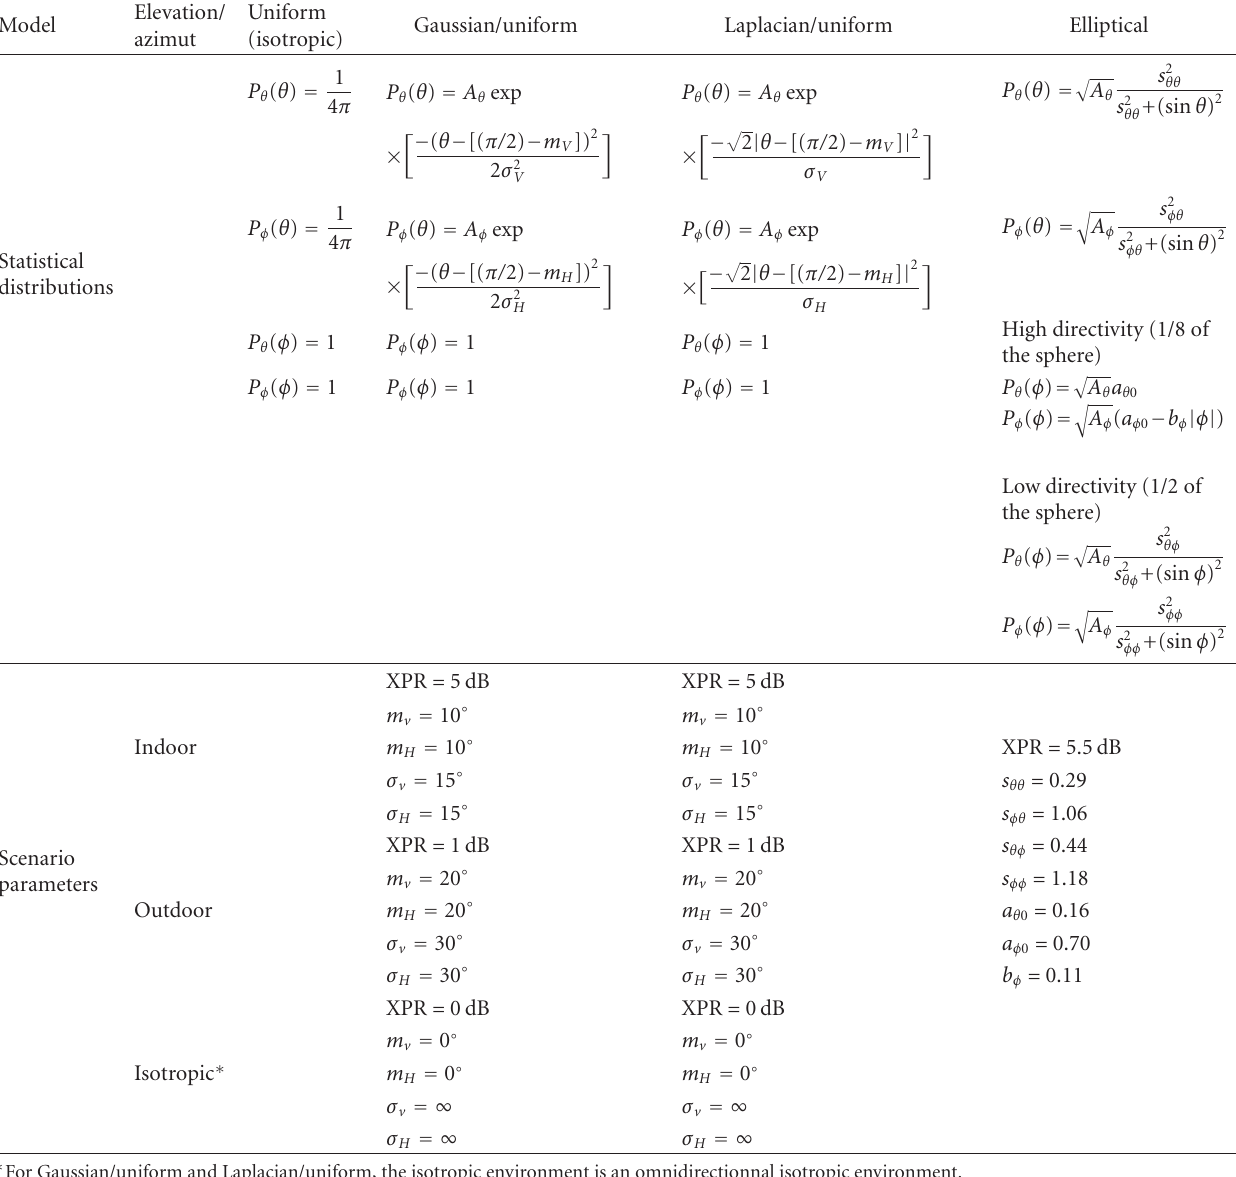
Table 1: Propagation models used to evaluate the performance of the antenna